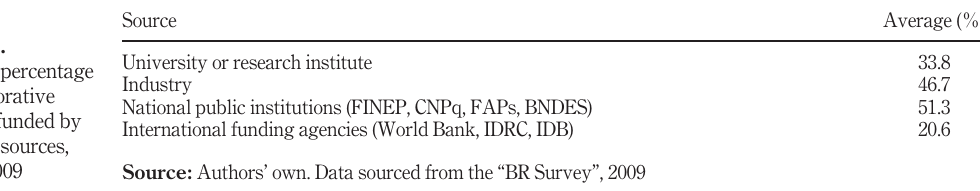
of collaborative projects funded by different